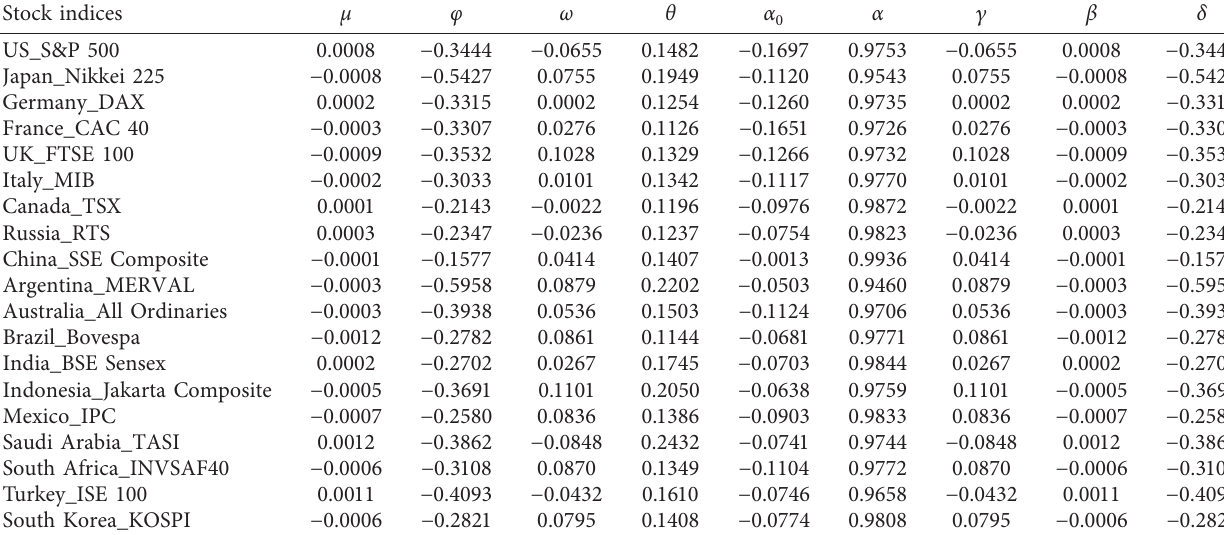
Table 2: The coefficient results estimated by the ARMA-APARCH-M